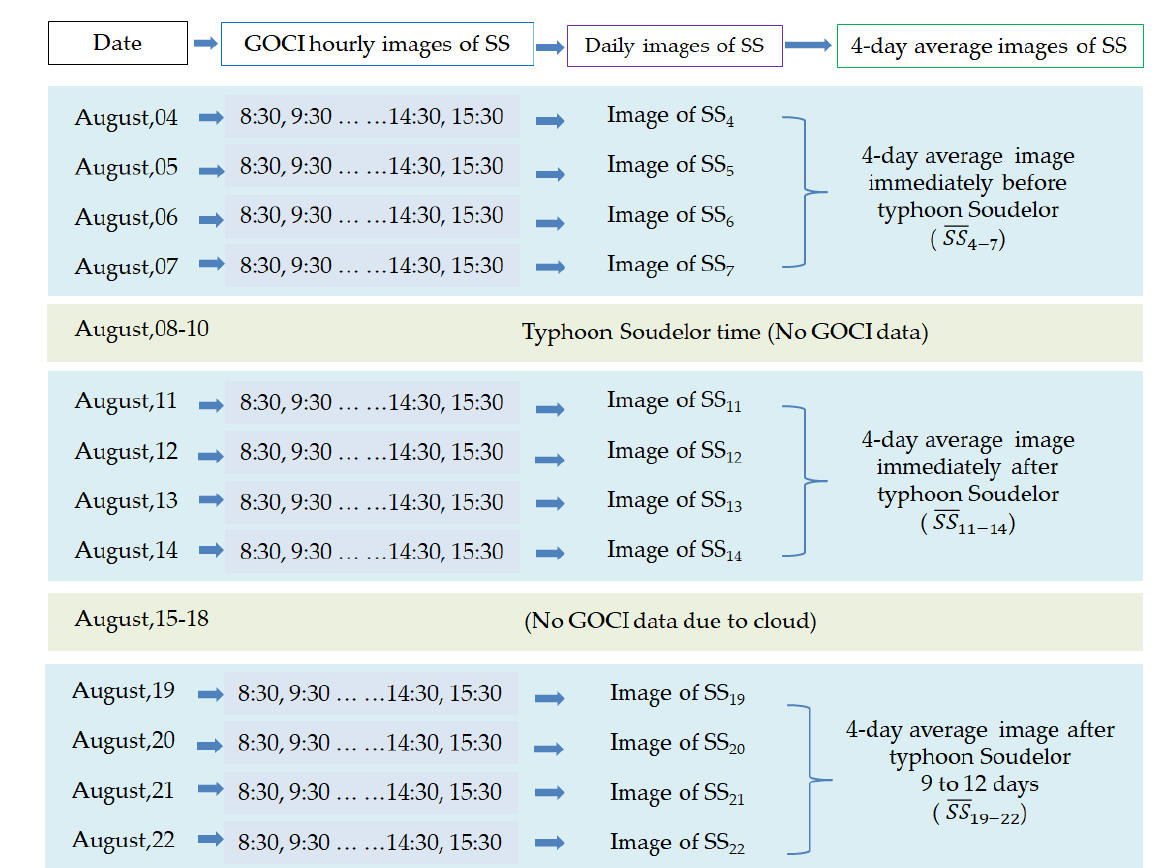
Figure 2. GOCI data processing for generating 𝑆𝑆̅̅̅ 4−7 , 𝑆𝑆̅̅̅ 11−14 , and 𝑆𝑆̅̅̅ 19−22 . SS: suspended sediment.